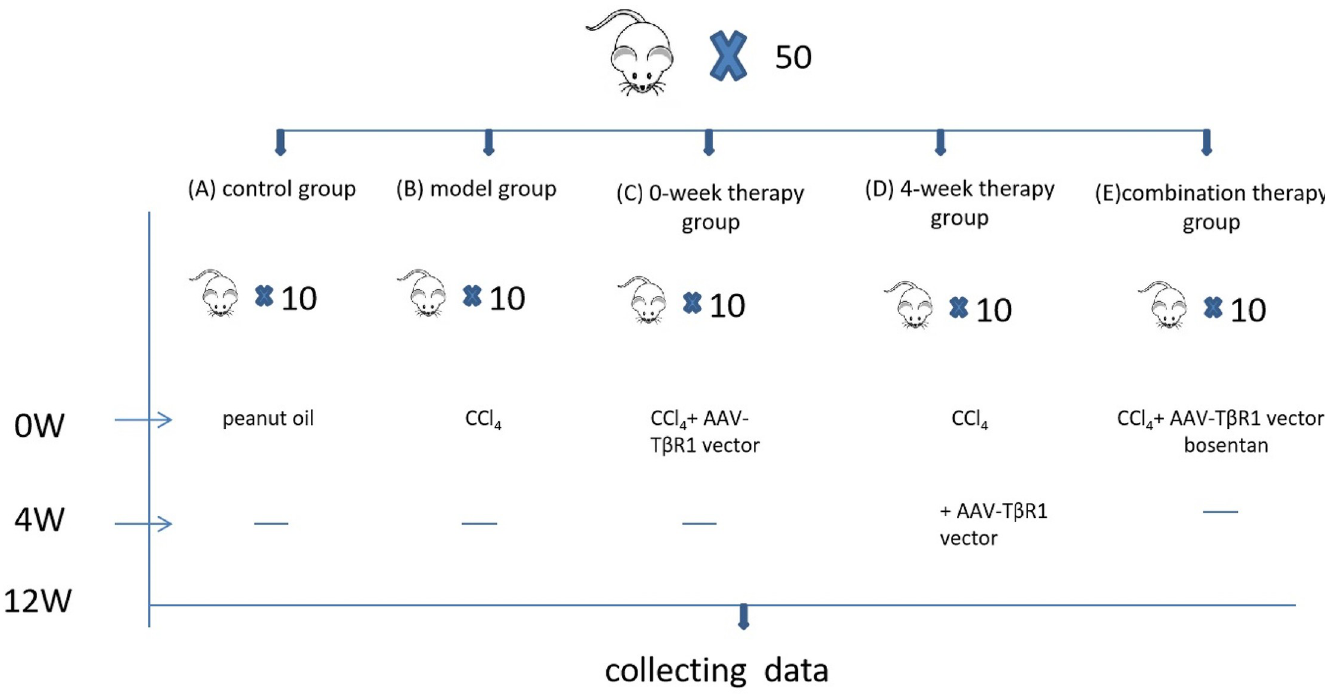
Fig 1. Experimental grouping